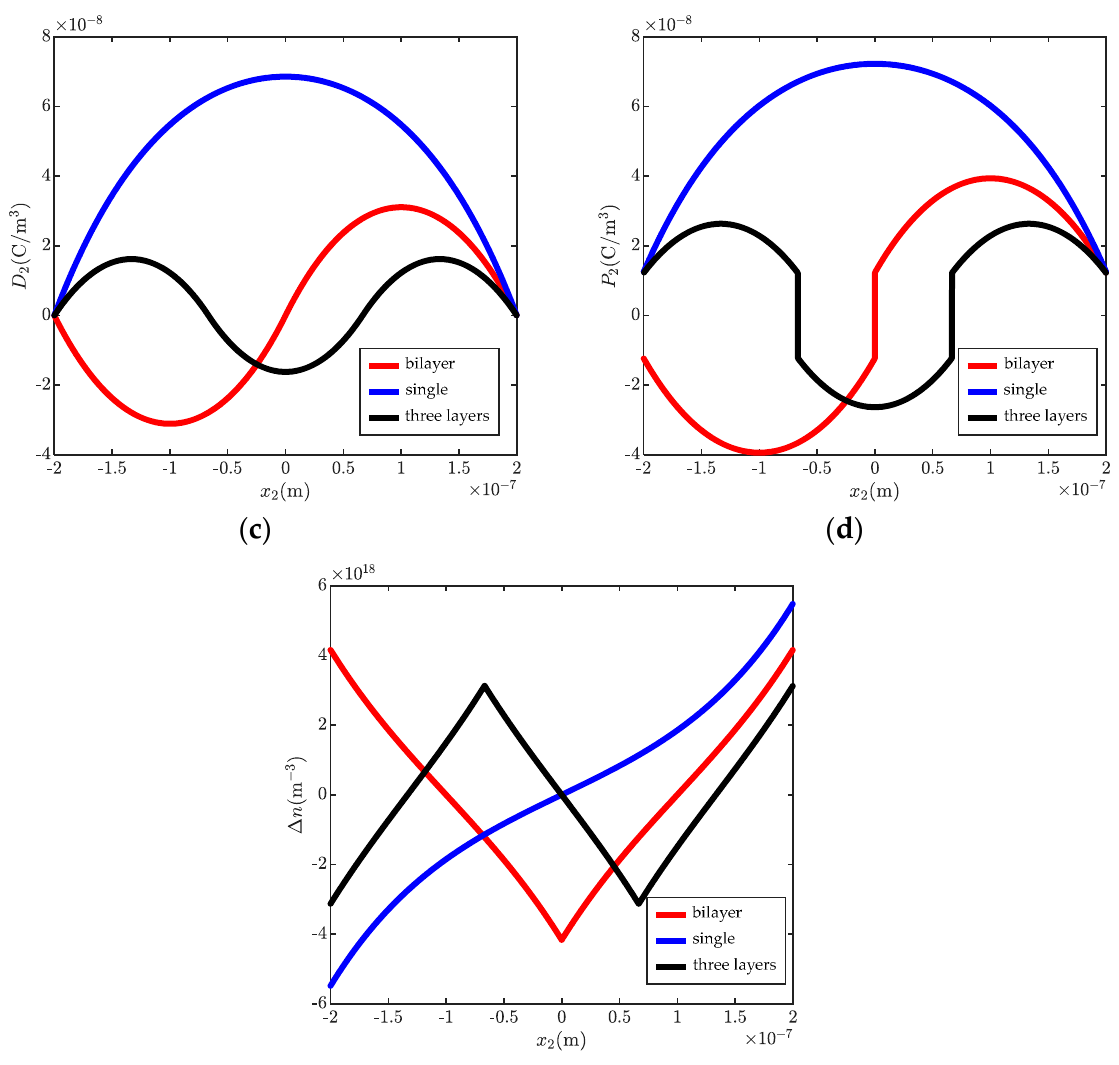
Figure 2. Electrostatics in a cantilever ZnO beam with different numbers of layers. ( a ) electric potential φ , ( b ) electric field E 2 , ( c ) electric displacement D 2 , ( d ) polarization P 2 , ( e ) carrier concentrations ∆ n .